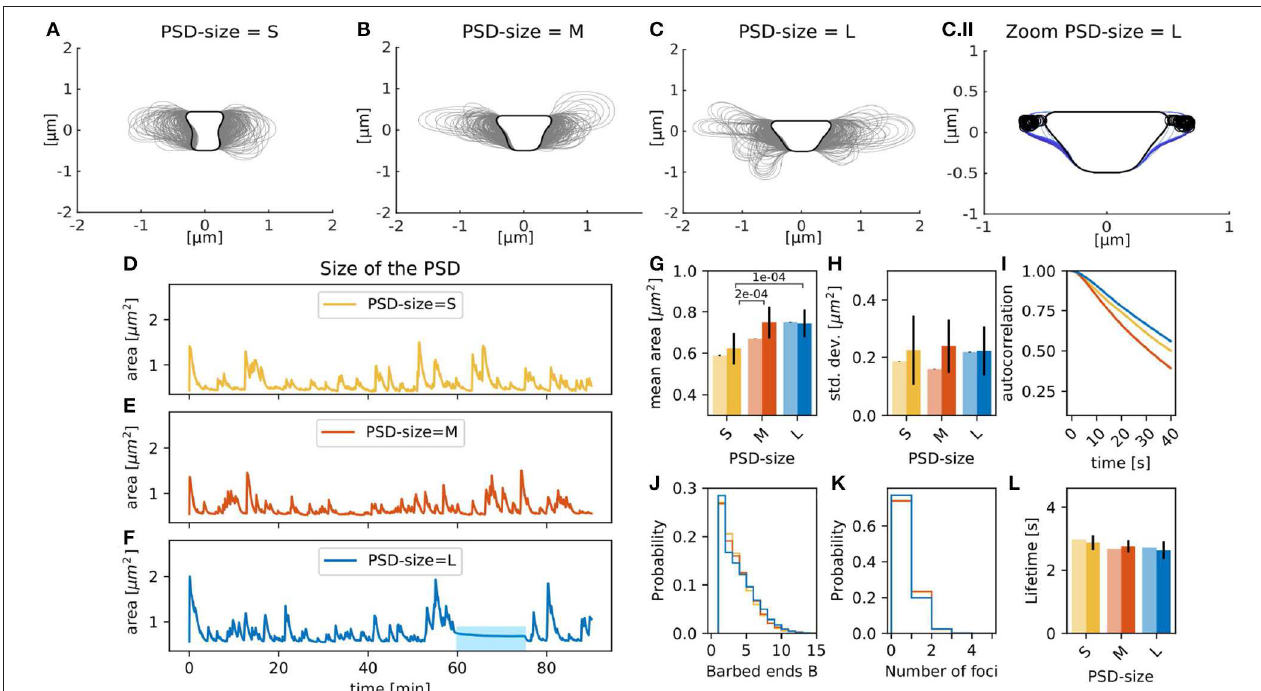
FIGURE 4 | Spines with varying PSD size. Spine shapes (gray lines, plotted every 15 s) over 90 min of simulation for (A) small, (B) medium, and (C) large sized PSDs. Black line corresponds to the resting shape. (C.II) Shapes of the large PSD-size spine between min 60 and 70 (color-coded from dark to light blue). Black open circles correspond to the nucleation points. (D–F) Evolution of the spine area over time. (G) Temporal mean over area in 90 min simulation (pale bars, errors are standard deviations over 50 bootstraps) and average of temporal means over fifteen 15 min simulations (saturated color, errors are standard deviations of the mean) over different PSD sizes. The p -value for significant Welch-tests is indicated. (H) Same as (G) but for standard deviation of the area fluctuations. (I) Autocorrelation functions for the area fluctuations in the 90 min simulations. (J) Histogram of the mean number of barbed ends at the polymerization foci at each time-step of the 90 min simulation. (K) Histogram of the active actin polymerization foci. (L) Mean lifetime of a focus, color-coded as in (G) .